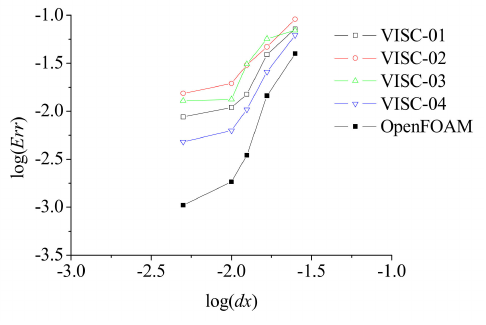
Figure 10. Convergence and error analysis of four viscosity force models for the different particle resolutions of a lid-driven